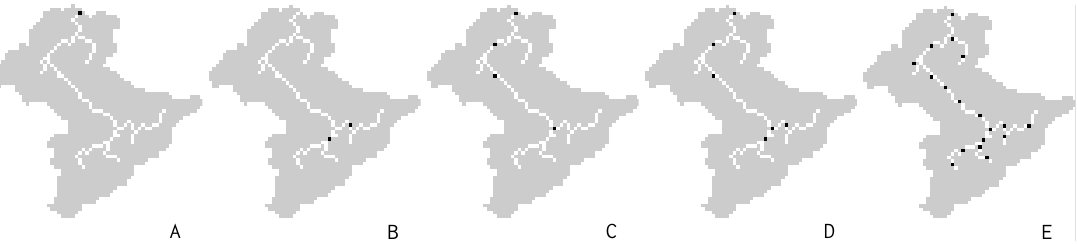
Fig. 4. Five cases of the discharge observation vector y k of increasing spatial extent. Discharge gauges contained in the observation vector are plotted in black. Channel delineation using Strahler stream ordering plotted in white pixels.